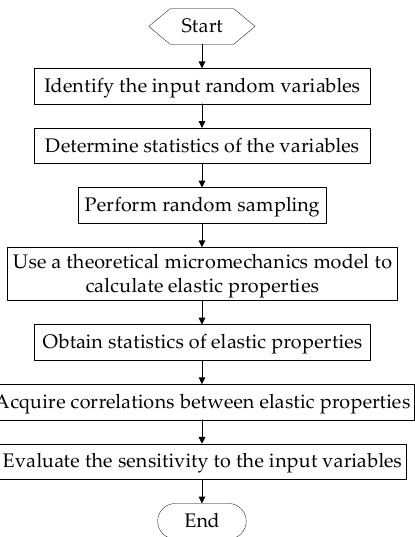
Figure 2. Flowchart for evaluating the probabilistic elastic properties of unidirectional composites.